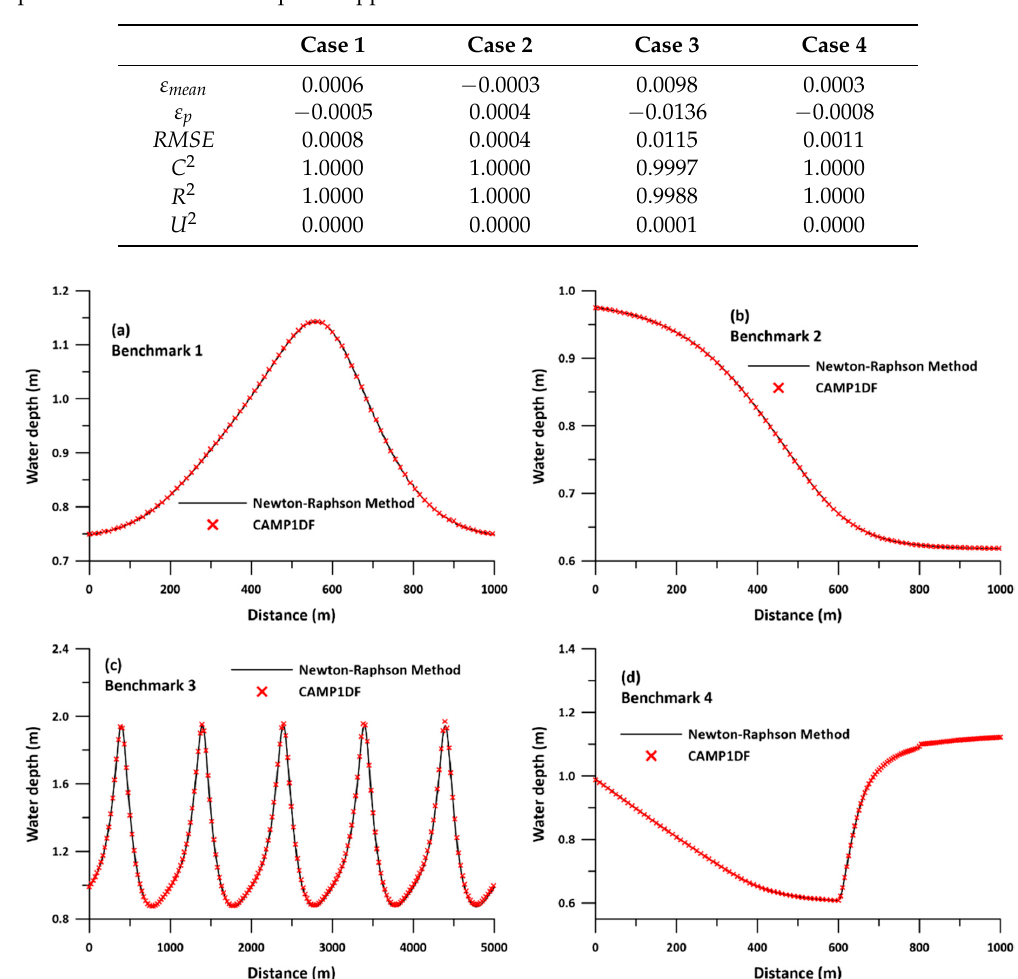
Table 3. Error calculations for the CAMP1DF kinematic wave (KIW) simulations of the benchmark problems and Newton–Raphson approximations.